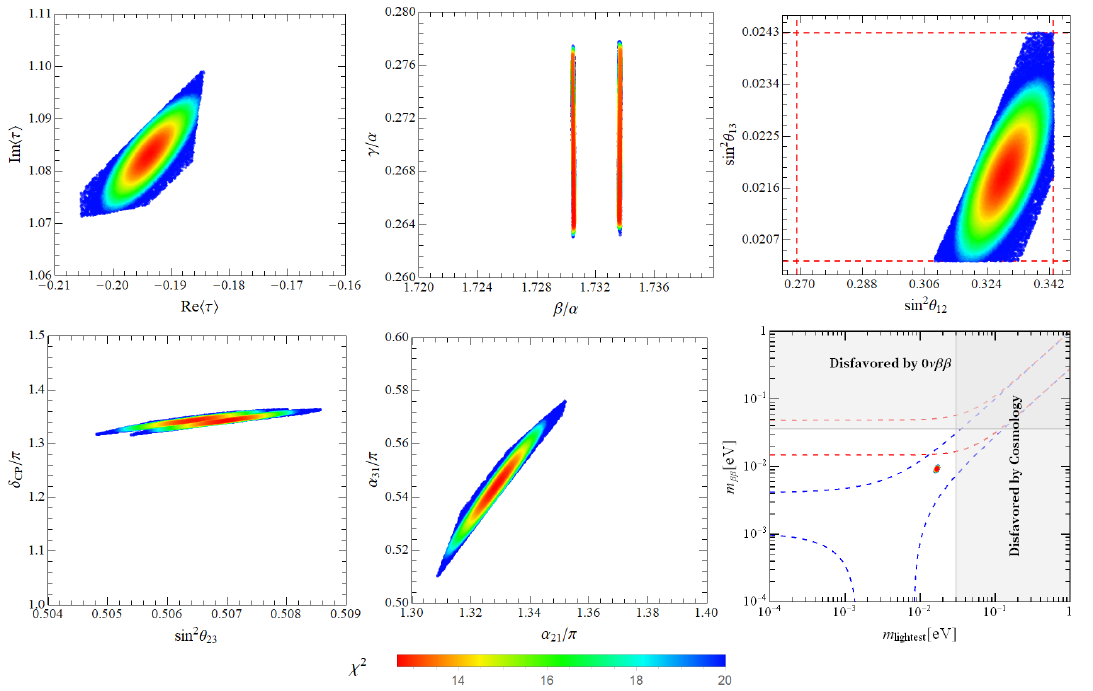
Figure 2 . The predicted correlations between the input free parameters, neutrino mixing angles, and CP violation phases in the minimal model. The plots only display the points that can reproduce the charged lepton masses, ∆ m 2 , ∆ m 2 and all the three lepton mixing angles at 3 σ level [89]. In 21 31 the top-right panel, the red dashed lines are the 3 σ bounds of the mixing angles. In the bottom right panel for m , the blue (red) dashed lines represent the most general allowed regions for normal ββ ordering (inverted ordering) neutrino mass spectrum, where the neutrino oscillation parameter are varied within their 3 σ ranges. Moreover, the vertical grey exclusion band stands for the most radical upper bound P m i < 0 . 12 eV form Planck [91]. The horizontal grey band represents the present i upper limit m (36 − 156) meV from KamLAND-Zen ββ ≤